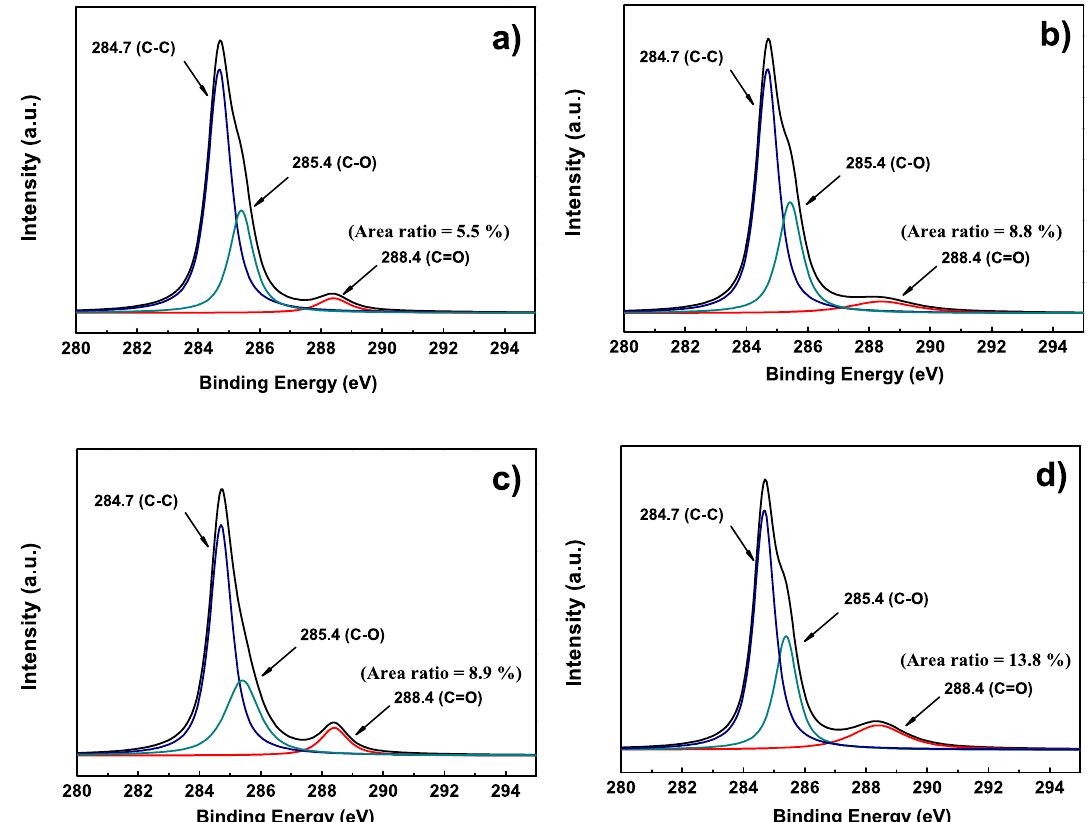
Figure 8. XPS spectra of the carbon framework of rice culm ( a ) R1, ( b ) R2, ( c ) R3, and ( d ) R4. The area ratios of the peak for C=O bonds have been calculated and shown in the